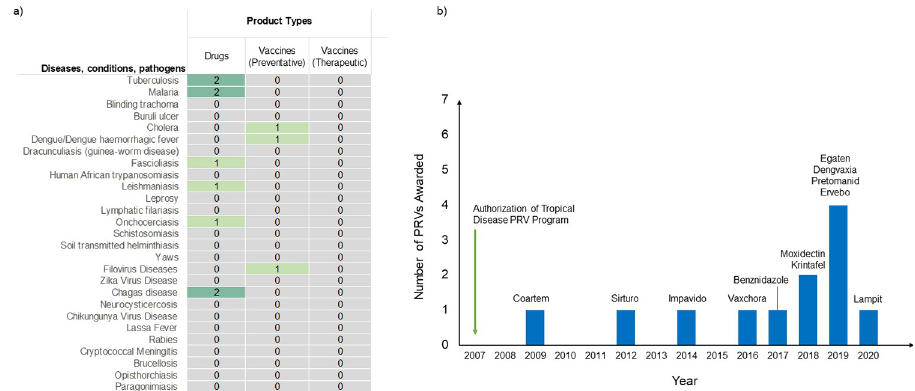
Fig 2. Products approved for the tropical disease PRV by the US FDA. (a) Diseases eligible for the tropical disease PRV program and number of products approved for PRV by FDA, by disease and product type. (b)